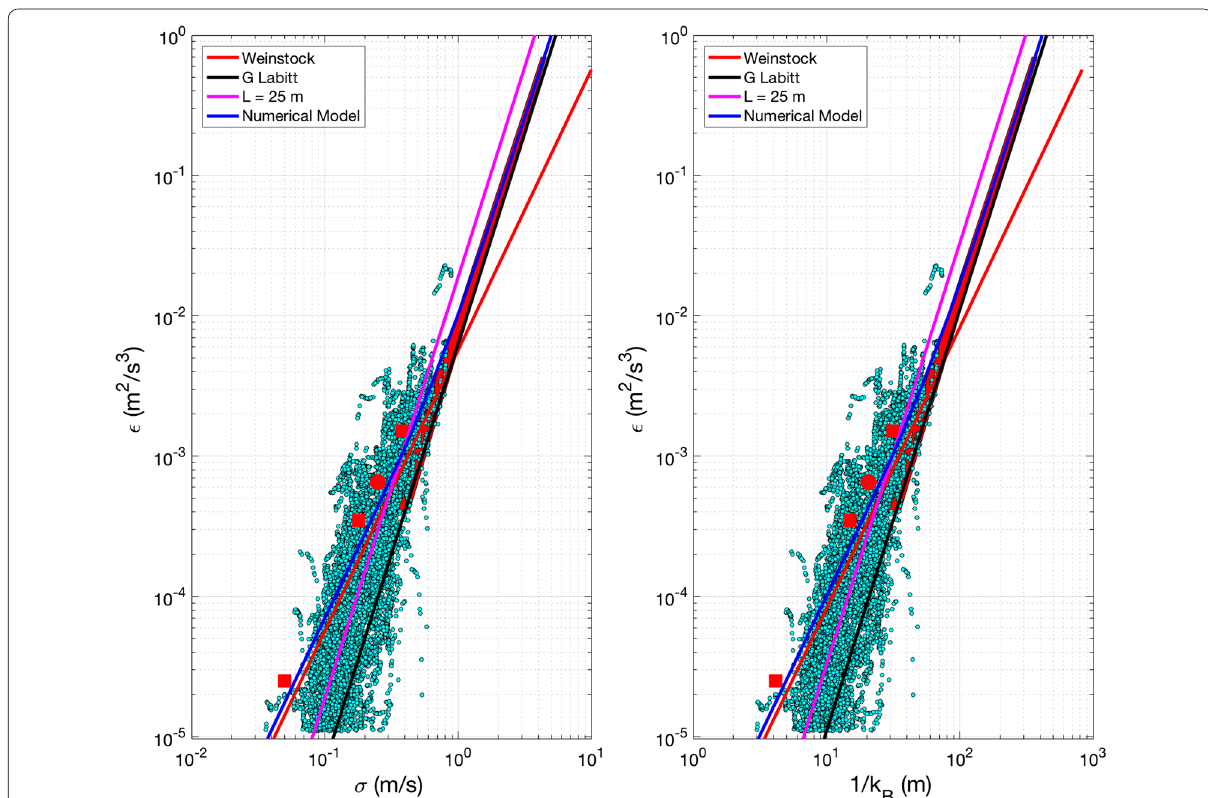
Fig. 2 Plot of the TKE dissipation rate ε against σ (left) and the corresponding buoyancy length scale 1/k B (right). Cyan circles show the UAV-measured ε plotted against radar-determined σ for all 16 flights made during the ShUREX 2016 campaign. The blue line shows the numerical model (Eq. 54). The red line shows the Weinstock (1978, 1981) formulation, while the black line is the Labitt formulation. The magenta line corresponds to Eq. (55) with L 25 m (see text). The green and magenta lines nearly overlap. Chen (1974) and other data cited in Fig. 2 of Weinstock = (1981) are shown by filled red polygons. The units and the figure aspect ratio are selected to be similar to that in Figure 2 of Weinstock (1981)